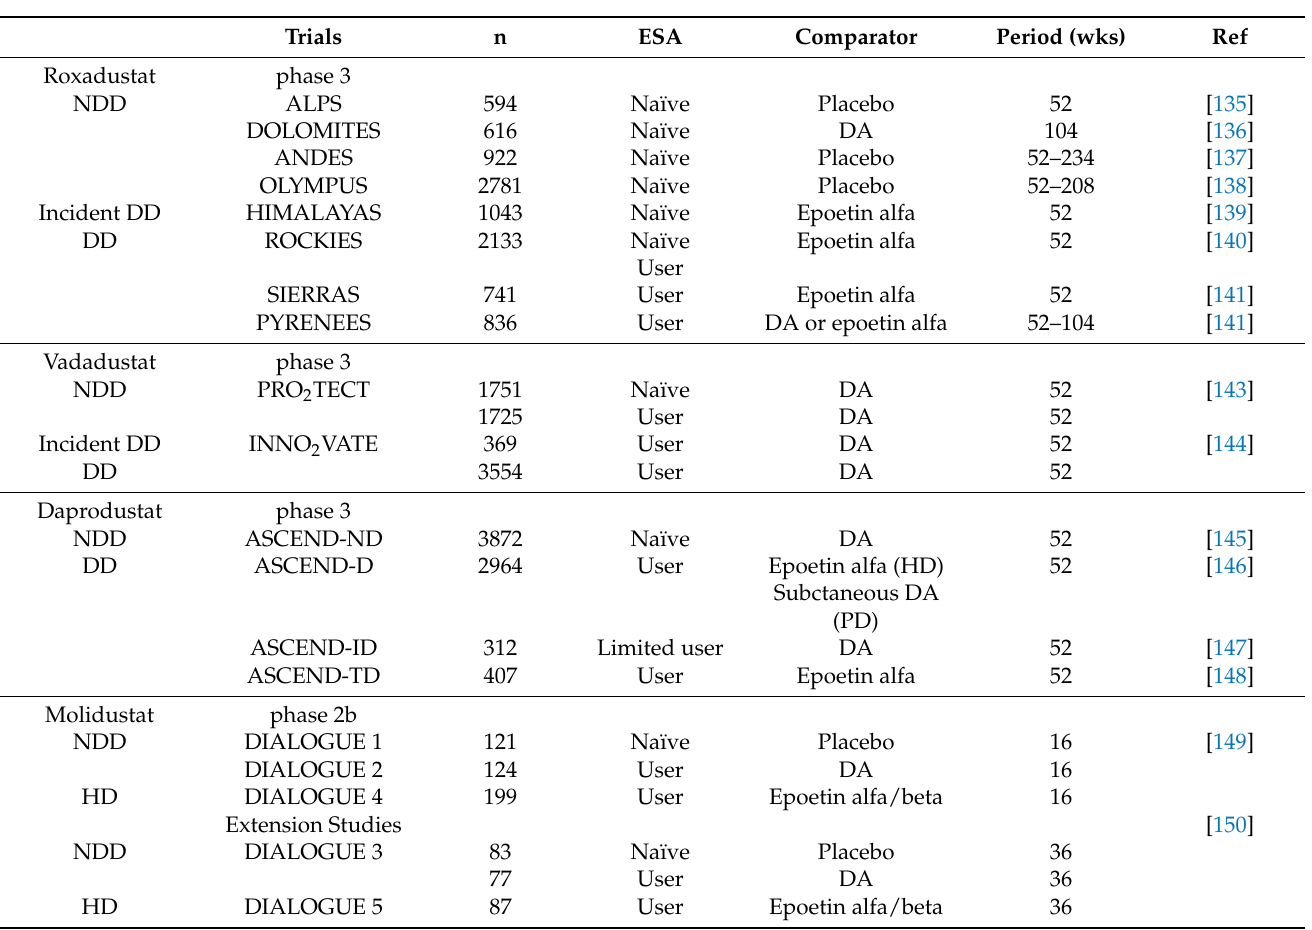
Table 3. Global studies of